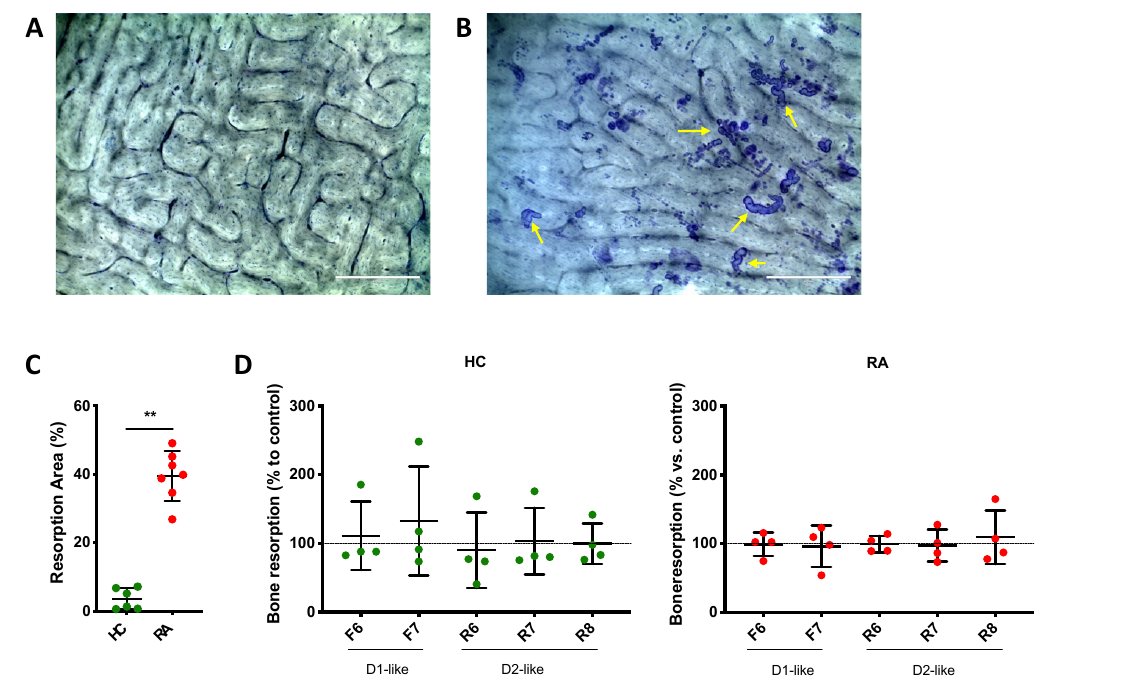
Figure 9. DR stimulation does not affect bone resorption. PBMCs were cultured on top of bone slices with OC differentiation medium for 14 days in the presence or not of DR agonists. Cells were then removed, and bone resorption pits were stained with toluidine blue. Percent of resorbed area compared to the total area was evaluated in three pictures for each condition. ( A , B ): representative pictures on toluidine-stained bone slices from a healthy donor. ( A ): empty bone, cultured without OC. ( B ): Bone slice culture with OC but without DR agonist. Yellow arrows indicate some of the resorption area present on the slice, as example. ( C ): percentage of bone resorption in cells from RA patients (red dots) and healthy controls (HC, green dots) cultured without DR agonists. ( D ): percentage of bone resorption in cells treated with DR agonists. Percentage of total resorbed area was normalized to control without DR agonist. HC n = 4–6, RA n = 4–7. F = Fenoldopam; R = Ropinirole; 6 = 10 − 6 M; 7 = 10 − 7 M; 8 = 10 − 8 M. Single dots represent mean value of individual patients. ** = p < 0.005 calculated with Mann Whitney test.